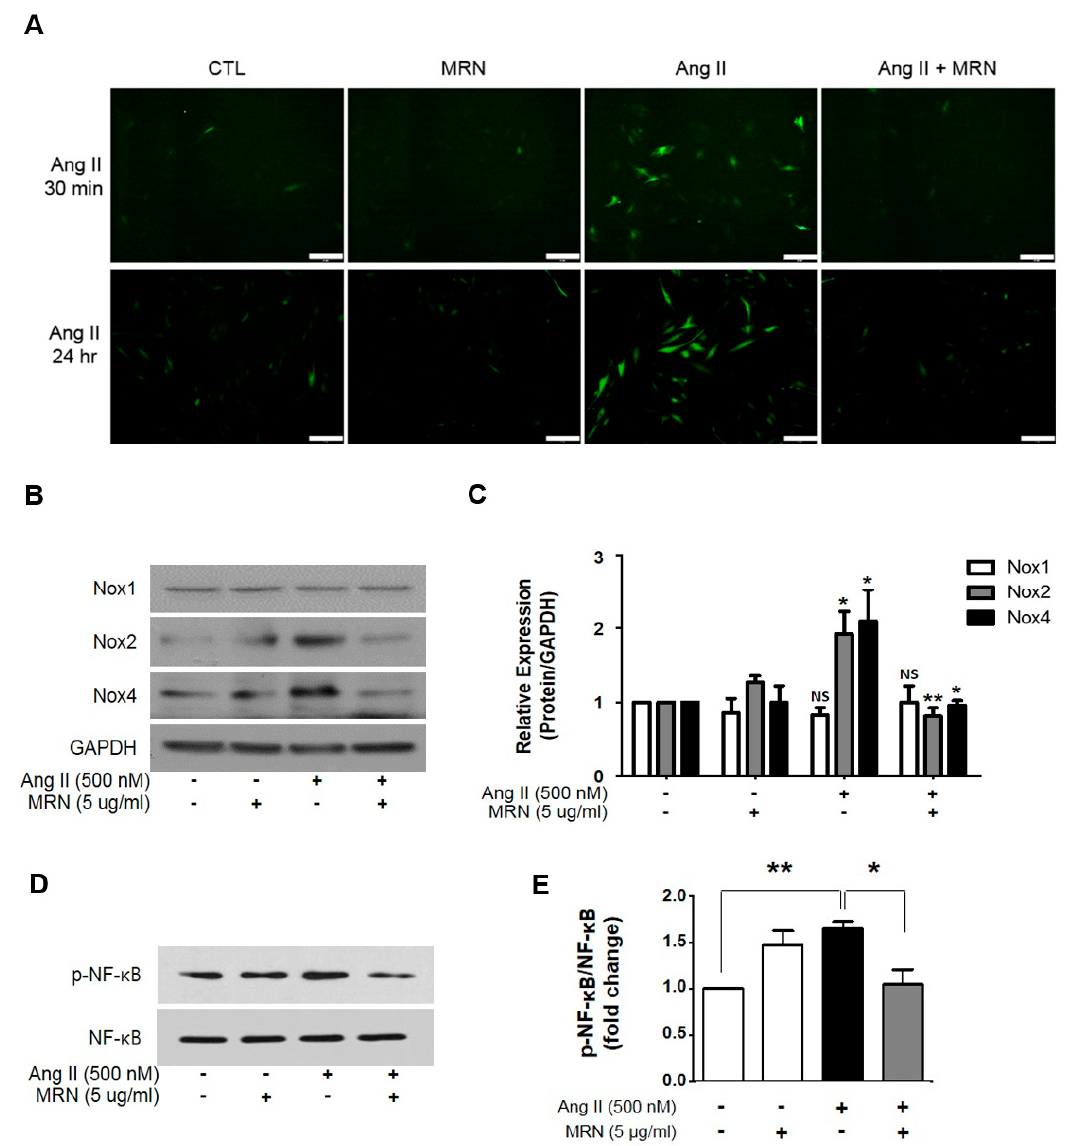
Figure 3. Nelumbo nucifera receptaculum extract (MRN) inhibits intracellular reactive oxygen species (ROS) by NADPH oxidases (NOXs) in Ang II-induced cardiomyocyte hypertrophy. H9c2 cells were treated with 500 nM Ang II for 30 min or 24 h in the presence or absence of MRN. ( A ) The e ff ect of MRN on intracellular ROS levels was measured using the CM-DCFDA assay and fluorescence microscopy. Scale bar = 50 µ m. Results are representative of three separate experiments. ( B,C ) H9c2 cells were treated with 500 nM Ang II for 24 h in the presence or absence of MRN, and the protein expression of NOX1, NOX2, NOX4, and GAPDH was examined by western blotting. Results are representative of four separate experiments. * p < 0.05 vs. DMSO-treated control, ** p < 0.01 vs. DMSO-treated control. ( D,E ) H9c2 cells were treated with 500 nM Ang II for 24 h in the presence or absence of MRN, and expression of NF- κ B and p-NF- κ B was examined by western blotting. Results are representative of four separate experiments. * p < 0.05, ** p < 0.01. The bars represent the mean ± SEM.